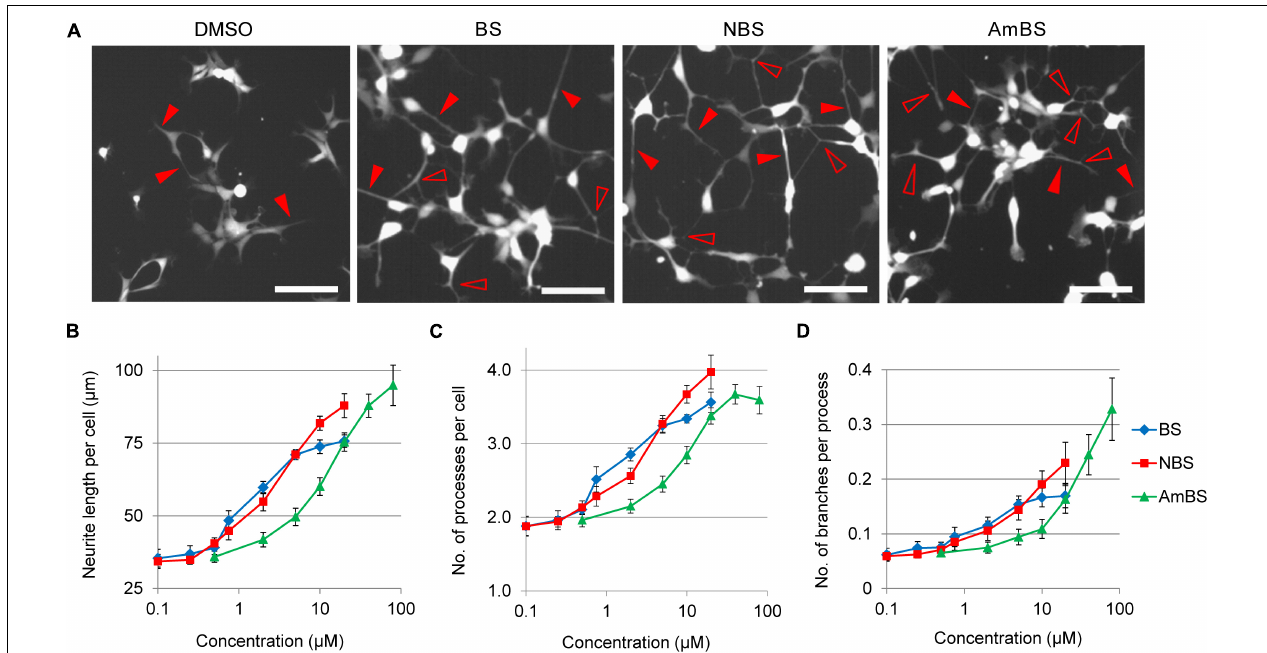
FIGURE 3 | Morphological changes in NPCs treated with blebbistatin or blebbistatin derivatives. (A) Representative images of eGFP-NPCs treated with vehicle (DMSO), 20 µ M blebbistatin (BS), 20 µ M para-nitroblebbistatin (NBS), or 40 µ M para-nitroblebbistatin (AmBS) for 4 h. Filled arrowheads point to selected processes, whereas empty arrowheads indicate branching points of the processes. Scale bars indicate 10 µ m. (B–D) Dose response curves for neurite length per cell, the number of projections per cell, and neurite branching in response to BS, NBS, or AmBS. The values were determined 3 h after treatment. The mean ± SEM from three independent experiments are